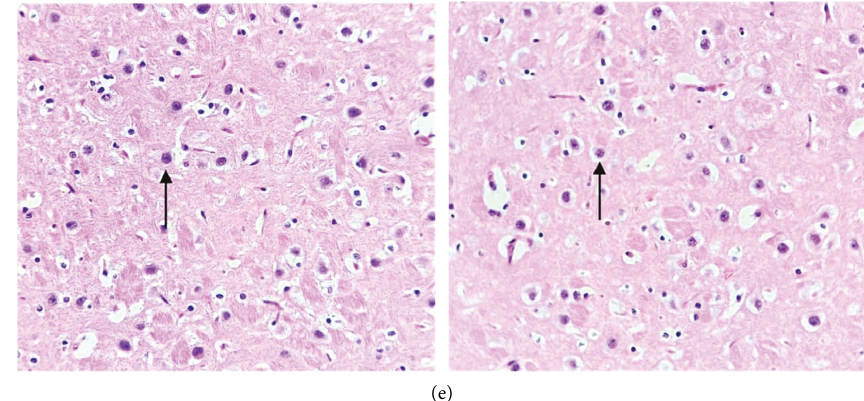
Figure 13: Histopathology studies: (a) disease control; (b) standard (pure drug patch); (c) test 1 (blank SLN patch); (d) test 2 (blank patch); (e) test 3 (drug+SLN patch). The ratio of TDC: total number of degenerative neuronal cells; TNC: total number of normal neuronal cells. TDC: TNC for the disease control group, 5.53:1; standard: 1:1.705; test 1: 1:2.21; test 2: 1.08:1; test 3: